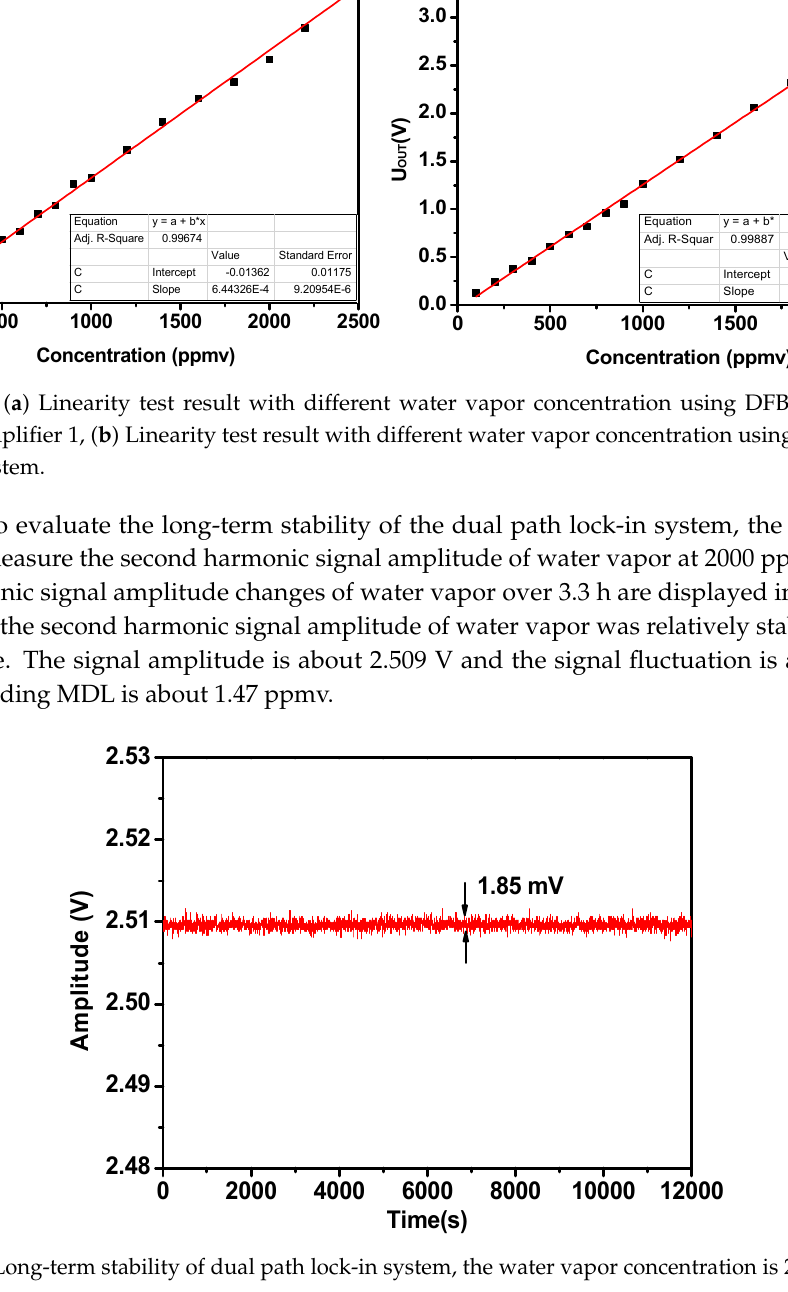
Figure 6. Long-term stability of dual path lock-in system, the water vapor concentration is 2000 ppmv.